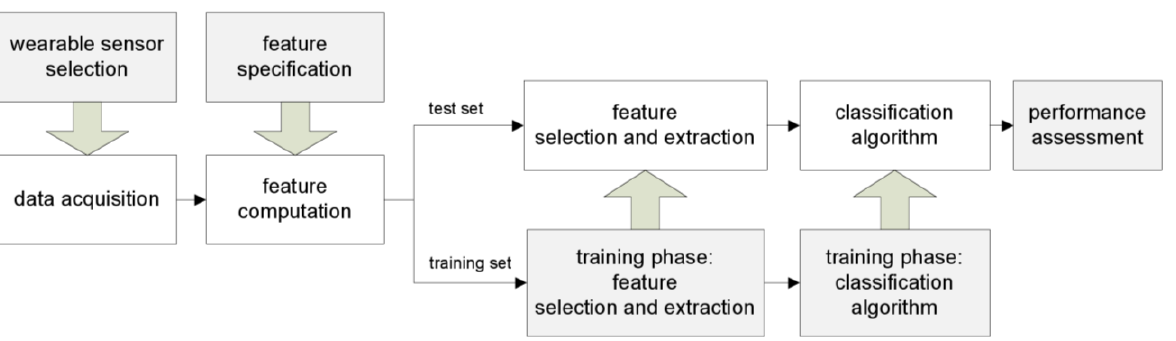
Figure 1. Conceptual scheme of a generic classification system with supervised